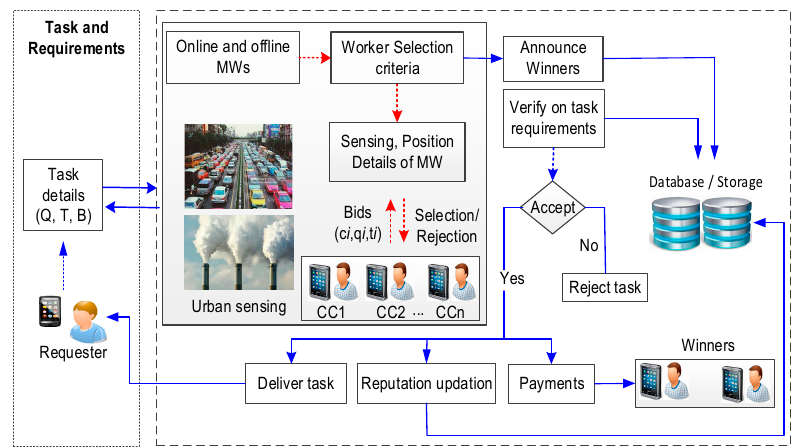
Figure 1. Proposed architecture of the Reputation, Quality-aware Recruitment for Platform ( RQRP ) method for task allocation and reward management. MW: mobile worker.